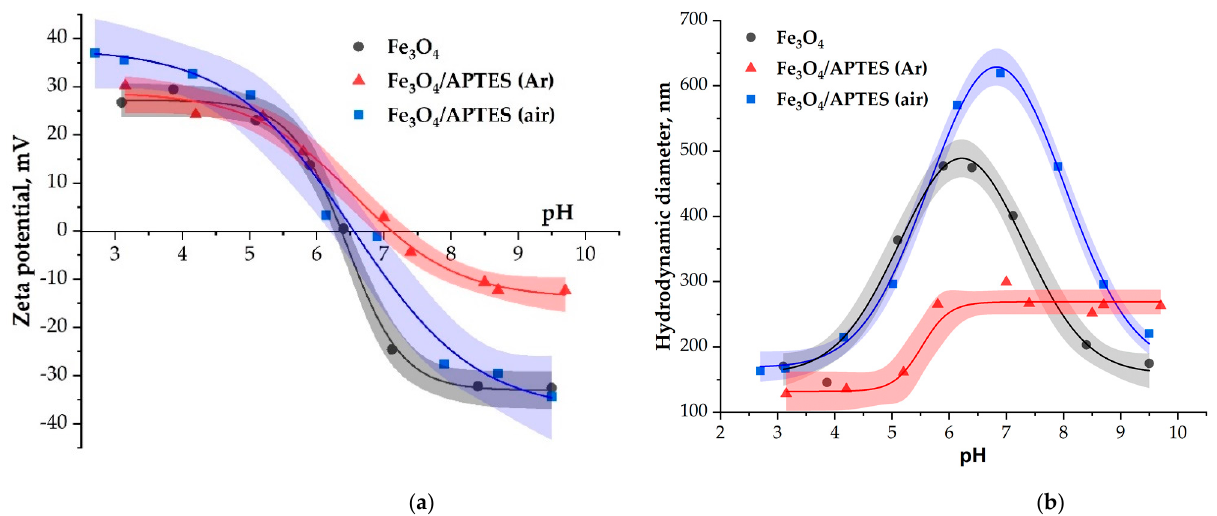
Figure 5. ( а ) Zeta potential and ( b ) hydrodynamic size of Fe 3 O 4 , Fe 3 O 4 /APTES (air) and Fe 3 O 4 /APTES(Ar) nanoparticles as a function of pH (0.01 М KCl). Value of zeta potential is given as ±0.2 of current pH.